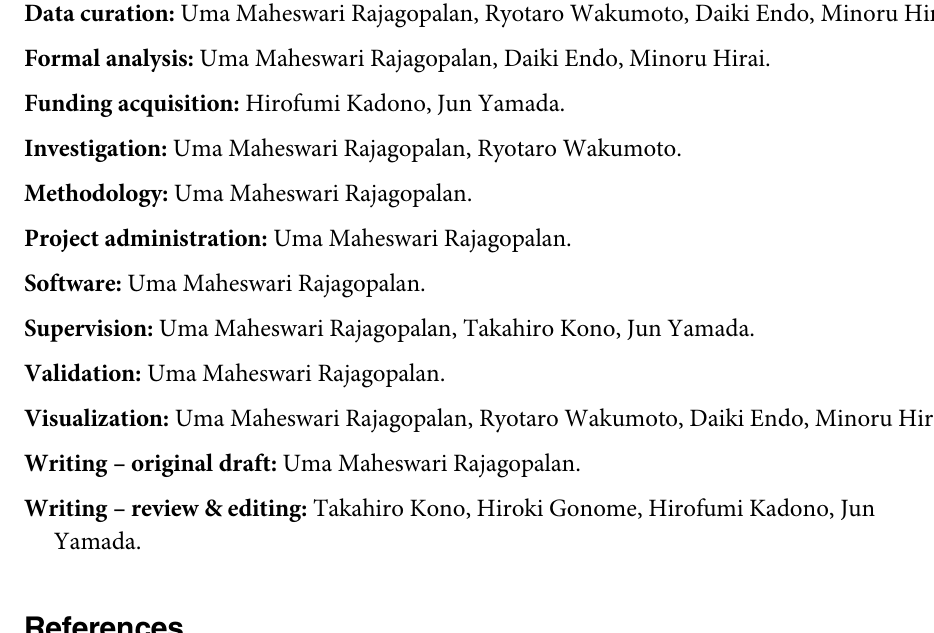
S1 Table. p-values of the results of t-test done under different frequencies with that under control of no sound for two different leaves of different